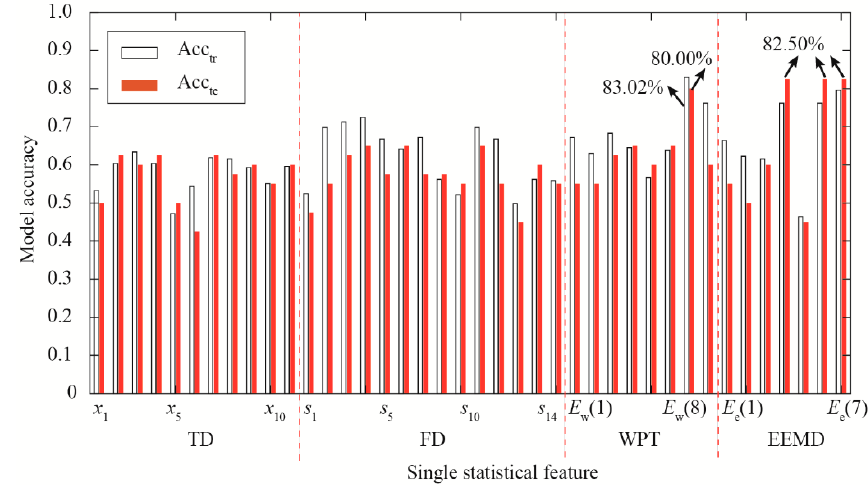
Figure 9. Model performance obtained from single statistical feature.